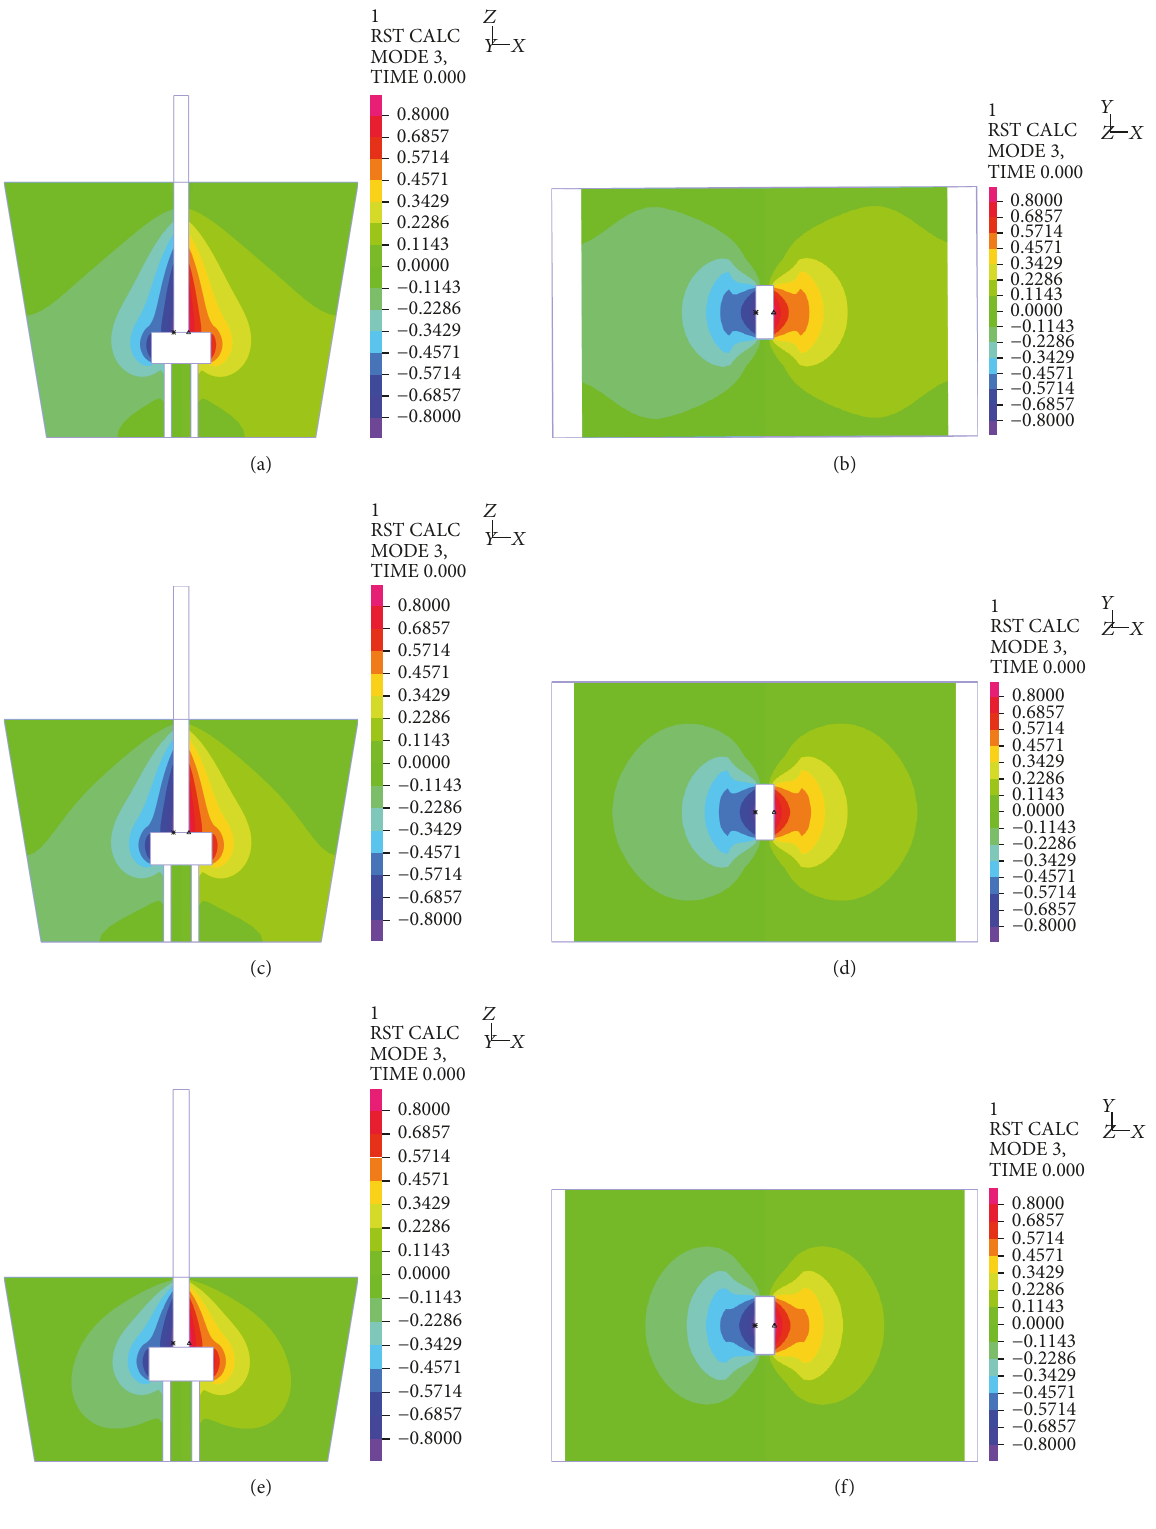
Figure 18: Nondimensional modal hydrodynamic pressures on the pier specimen without tip mass for the second mode along 𝑥 -axis; profiles for a water level, 𝐻 w , of 1.8m along cutting planes: (a) 𝑦 = 0 m and (b) 𝑧 = 0.7 m; profiles for a water level, 𝐻 w , of 1.5 m along cutting planes: (c) 𝑦 = 0 m and (d) 𝑧 = 0.7 m; profiles for a water level, 𝐻 w , of 1.2m along cutting planes: (e) 𝑦 = 0 m and (f) 𝑧 = 0.7